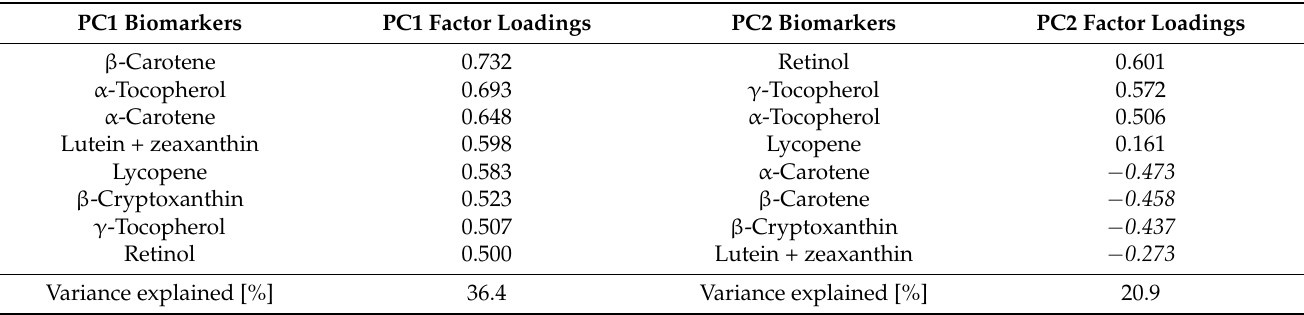
Table 3. Factor loadings for principal components 1 and 2 ( n =